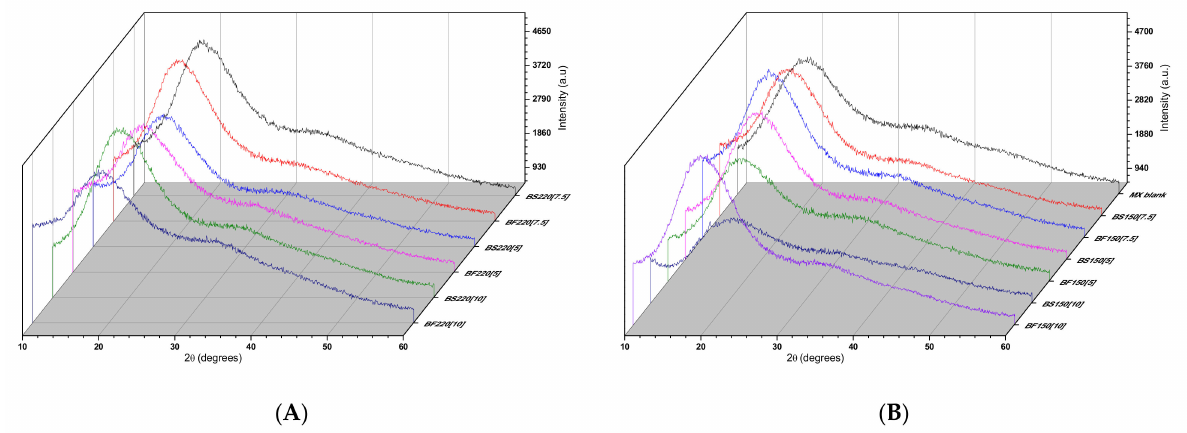
Figure 6. XRD diffractograms of the BJ-MX powders obtained under different drying conditions. Samples prepared at ( A ) 150 ◦ C, and ( B ) 220 ◦